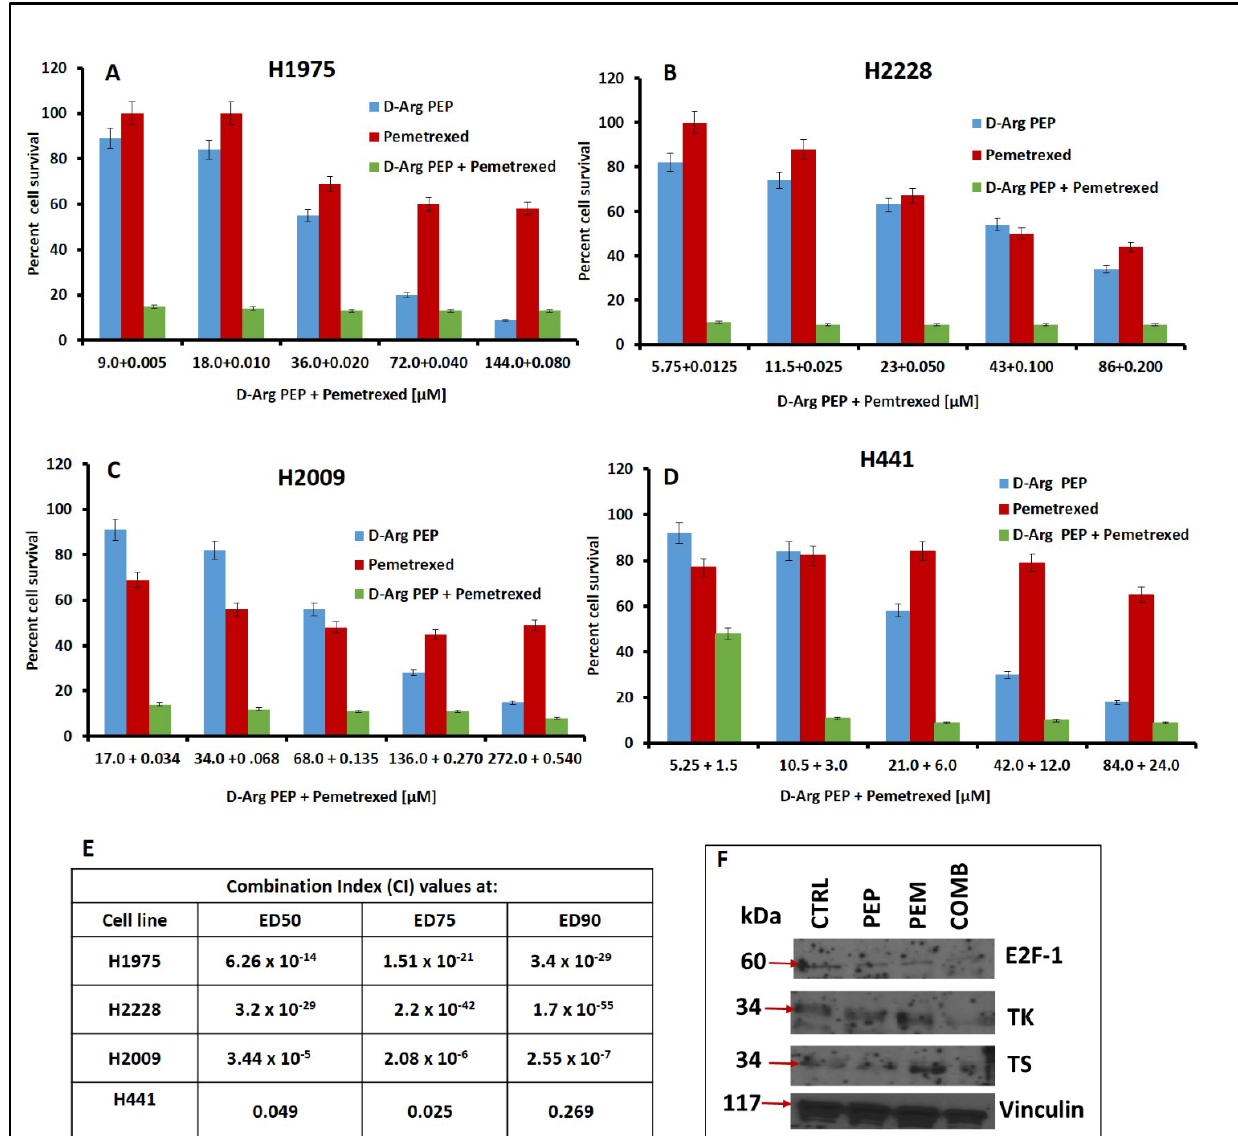
Figure 5. D-Arg PEP is highly synergistic in combination with pemetrexed against non-small cell lung cancer cell lines ( A – D ). D-Arg PEP and pemetrexed concentrations added in combination plates are shown on x axis and the percentage cell survival (compared to untreated control) is shown on y axis. The drugs were added in combination at constant ratio as per IC 50 value concentration for individual drugs. The given concentration was also added as a single drug in individual plates. The combination index (CI) values obtained by Chou–Talalay analysis are tabulated ( E ). Western blot showing E2F-1, thymidine kinase (TK), thymidylate synthase (TS), and vinculin (loading control) in the H2009 cell line after treatment. Lane 1: untreated control; lane 2: D-Arg PEP (IC 50 concentration); lane 3: pemetrexed (IC 50 concentration); lane 4: combination of D-Arg PEP and pemetrexed ( F ). The uncropped Western blots are shown in Figure S4A.